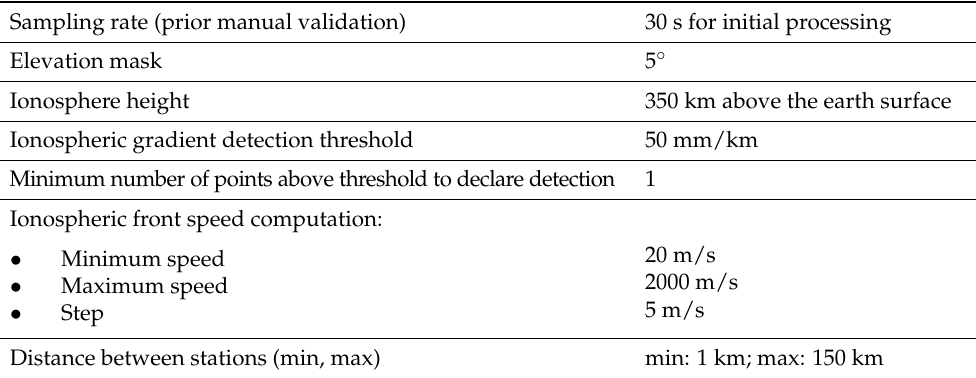
Table 2. Summary of the basic GIMA parameter settings applied for data processing.